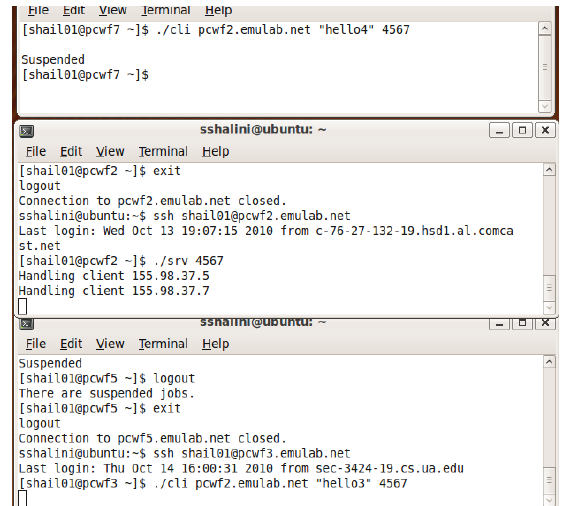
Fig. 21: pcwf2 handling two